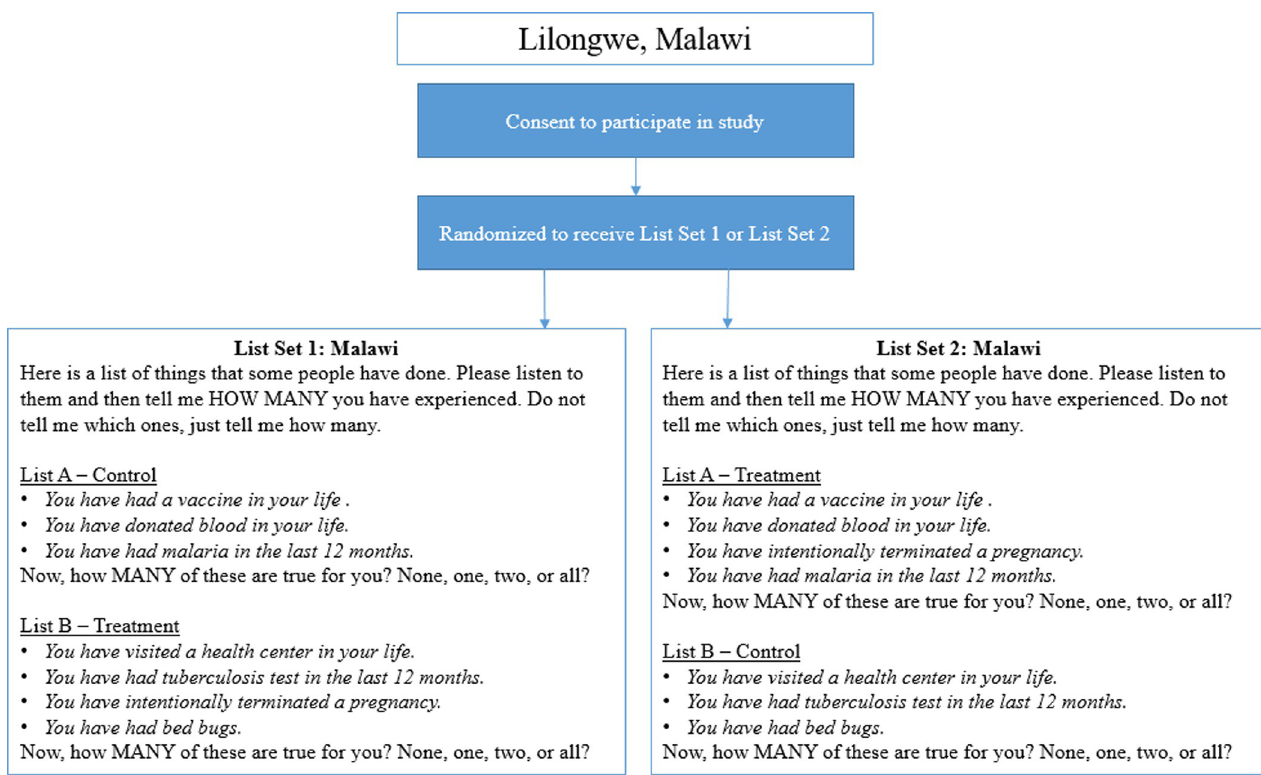
Fig 1. Diagram indicating participant randomization to one of two list experiment sets, as well as the full text of the list experiment questions. List experiment sets presented below for the Lilongwe, Malawi survey.